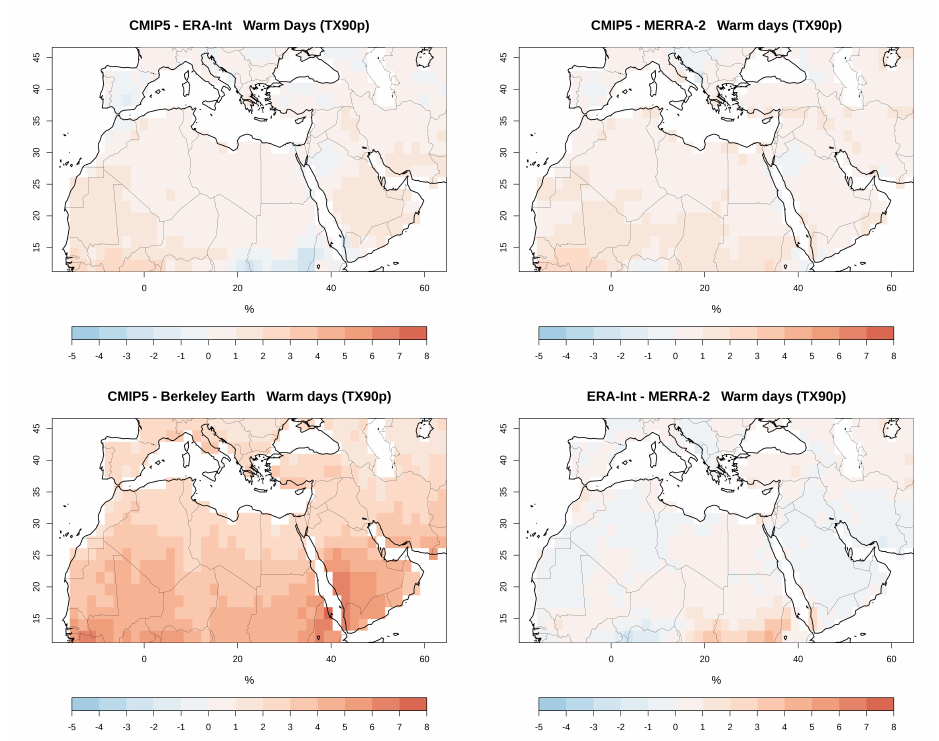
Figure A4. Same as Figure A1 but for the Warm Days (TX90p).